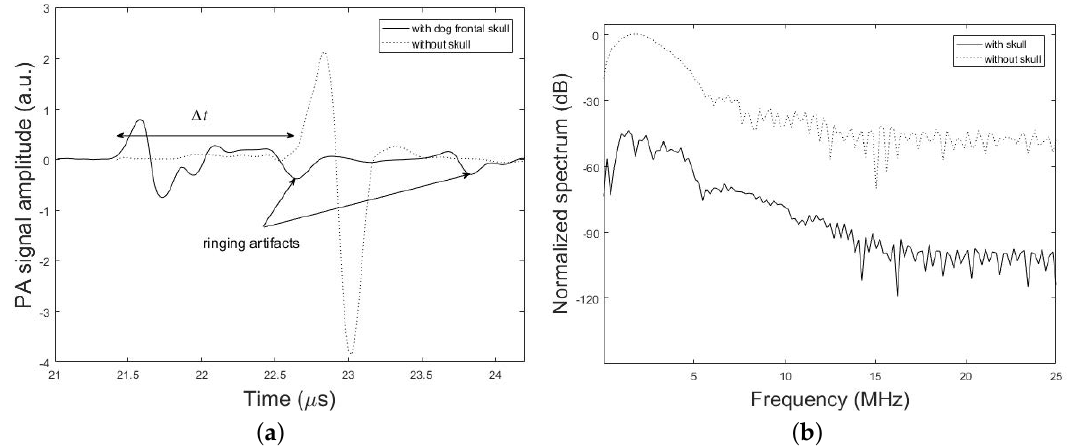
Figure 7. Experimental results. ( a ) PA signal amplitude obtained with and without dog frontal skull bone. The skull bone was placed in the detection path. ( b ) Corresponding frequency spectrum of the experimental PA signals.